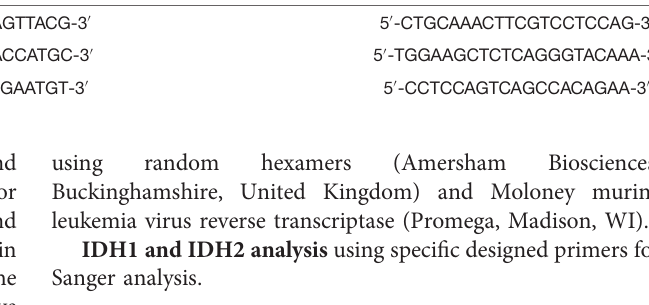
TABLE 5 | List of primers for